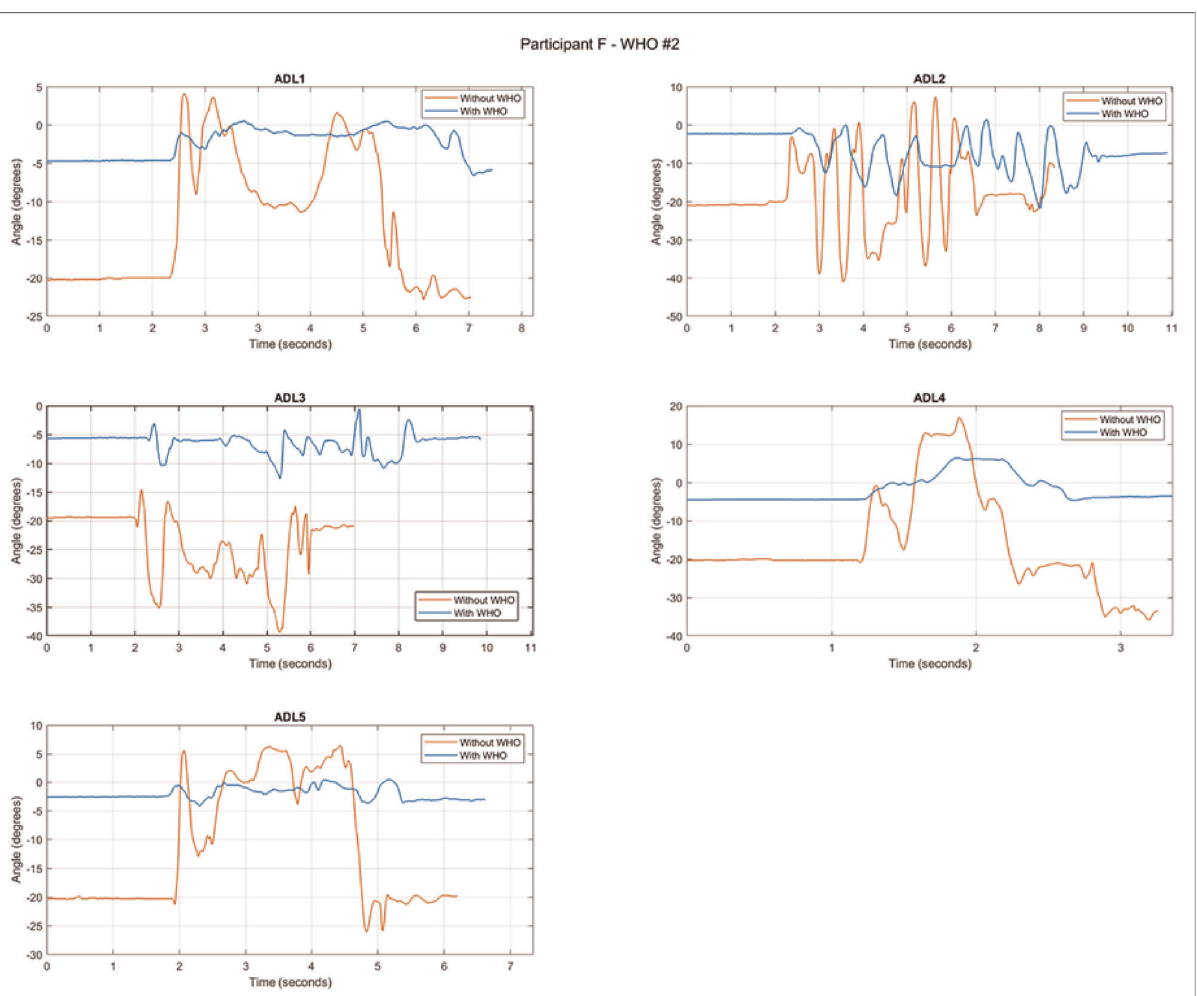
FIGURE 5 Percentage of time when the wrist adopted a position of radial deviation by WHOs across all ADLs. The outliers are shown with a circle, with the mean of each group shown by the line. Statistical signi fi cance is given in Table 6